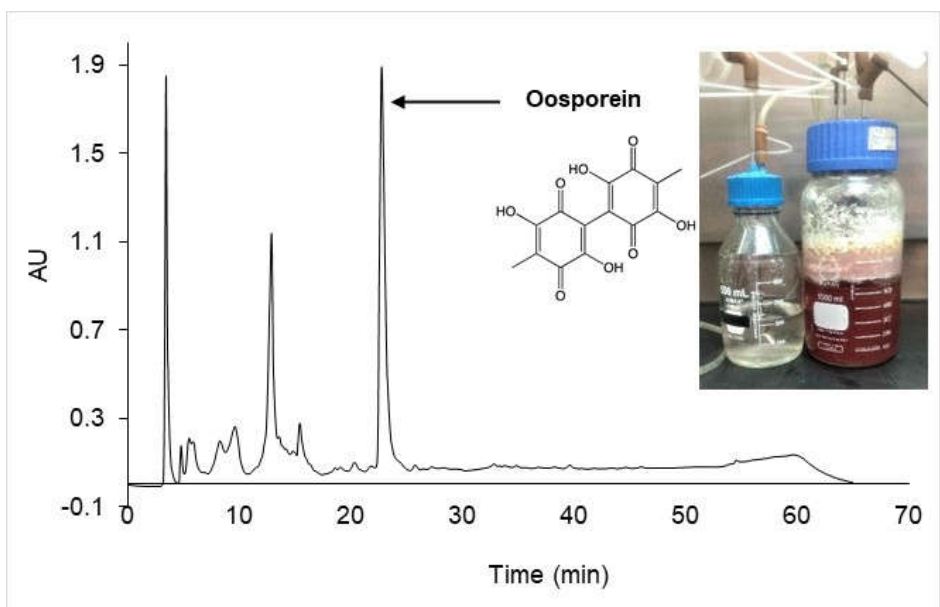
Figure 5. HPLC chromatogram of metabolites produced by B. bassiana PQ2 in the biofilm bioreactor.